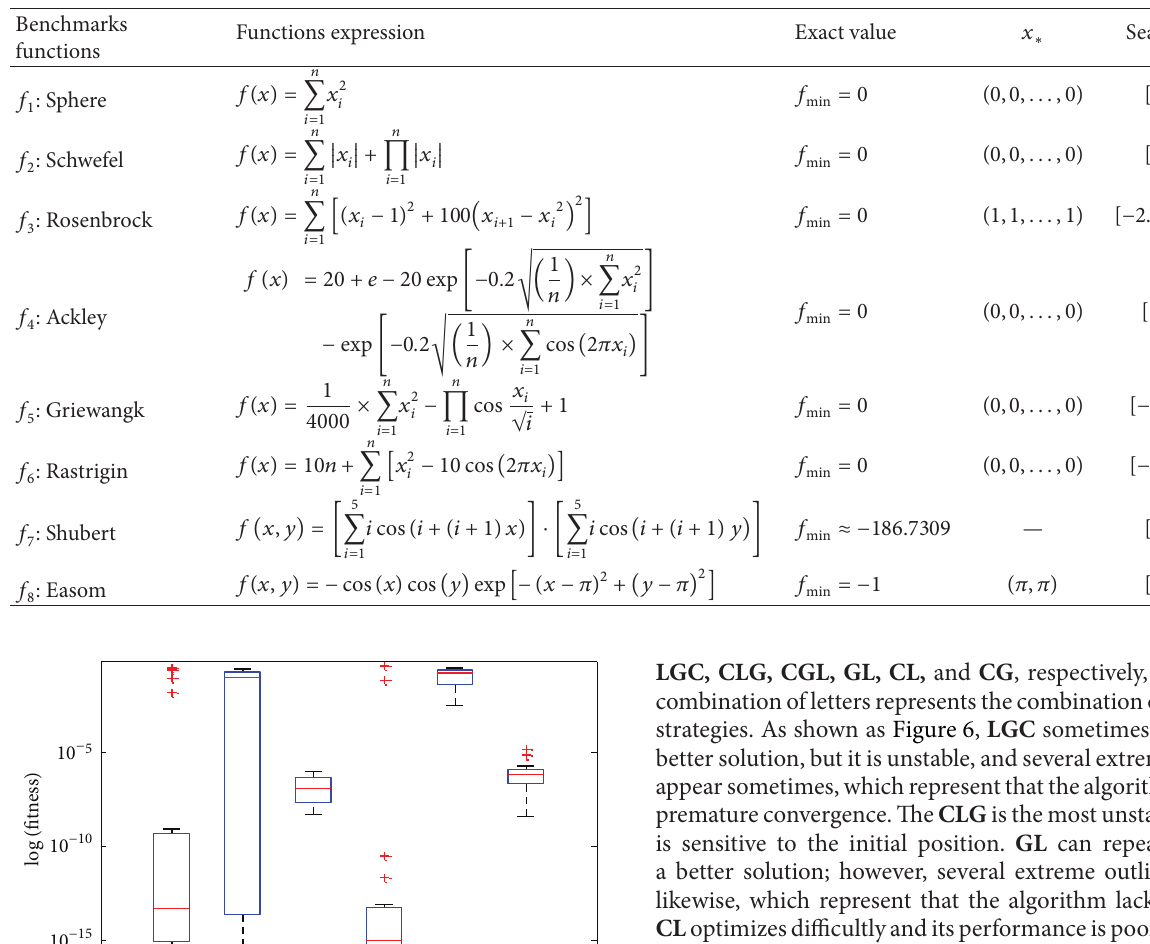
Table 1: Benchmarking test functions.